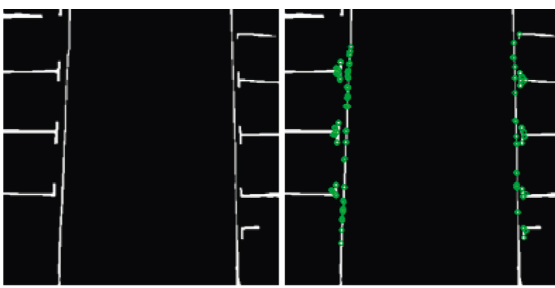
Figure 10: ORB feature detection